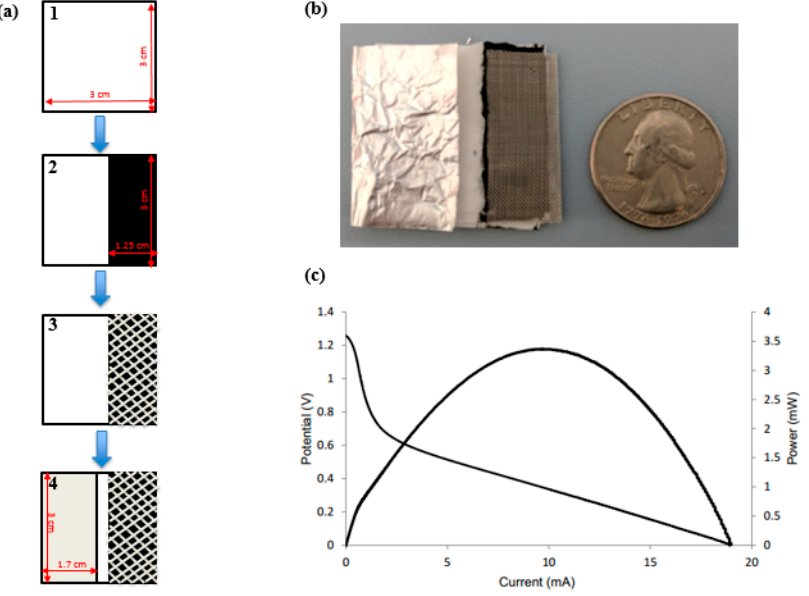
Figure 1. ( a ) Fabrication process of the battery in four steps: (1) folded Kim Wipe; (2) addition of activated carbon ink; (3) addition of steel mesh current collector; (4) addition of aluminum anode. ( b ) Design of a paper-based battery with the optimal dimensions of chip size and electrode size compared to the size of a US quarter. ( c ) Polarization curve of the optimal battery using 1.5 M KOH.